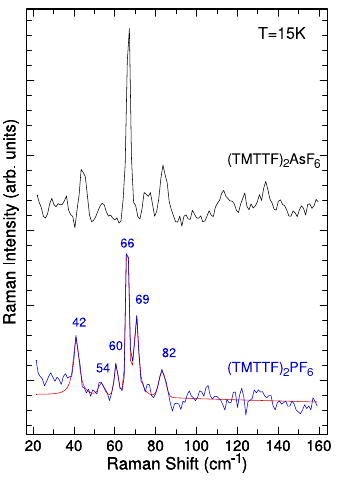
Figure 24. Raman spectra of (TMTTF) λ = 647 nm laser line in the ( b (cid:48) , b (cid:48) )-polarization at T = 15 K. For the assignment of the modes, confer with Table 7.